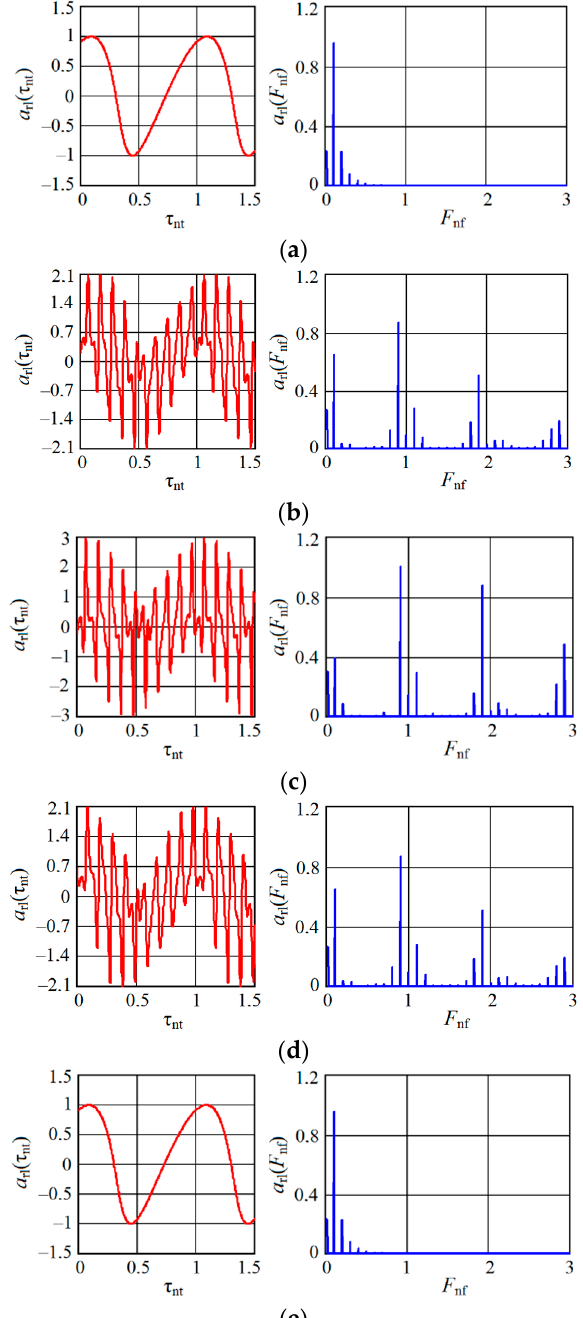
( ) a and spectral ( ) a F diagrams of the autodyne signals calculated for the Figure 8. Time τ Figure 8. Figure 8. Time a rl ( τ nt ) and spectral a rl ( F nf ) diagrams of the autodyne signals calculated rl nt rl nf for the oscillator with AM in the presence of FM ( k FM = 1 ) and di ff erent values r nd : ( a ) r nd = 0; 1 k ) and different values r : ( a ) = 0 r ; ( b ) oscillator with AM in the presence of FM ( = FM nd nd ( b ) r nd = 0.25; ( c ) r nd = 0.5; ( d ) r nd = 0.75; ( e ) r nd = .